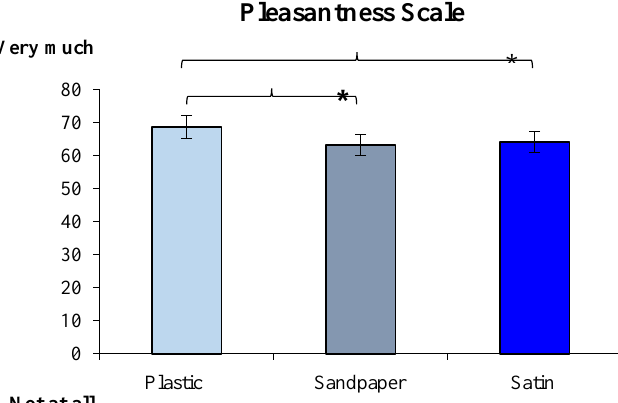
Figure 3. The participants’ mean judgments on the scale measuring pleasantness perception for both kinds of water as a function of the texture of the glass in which the liquid was served. Error bars represent the standard error of the mean. Asterisks represent Newman-Keuls significant differences at p < 0.05.